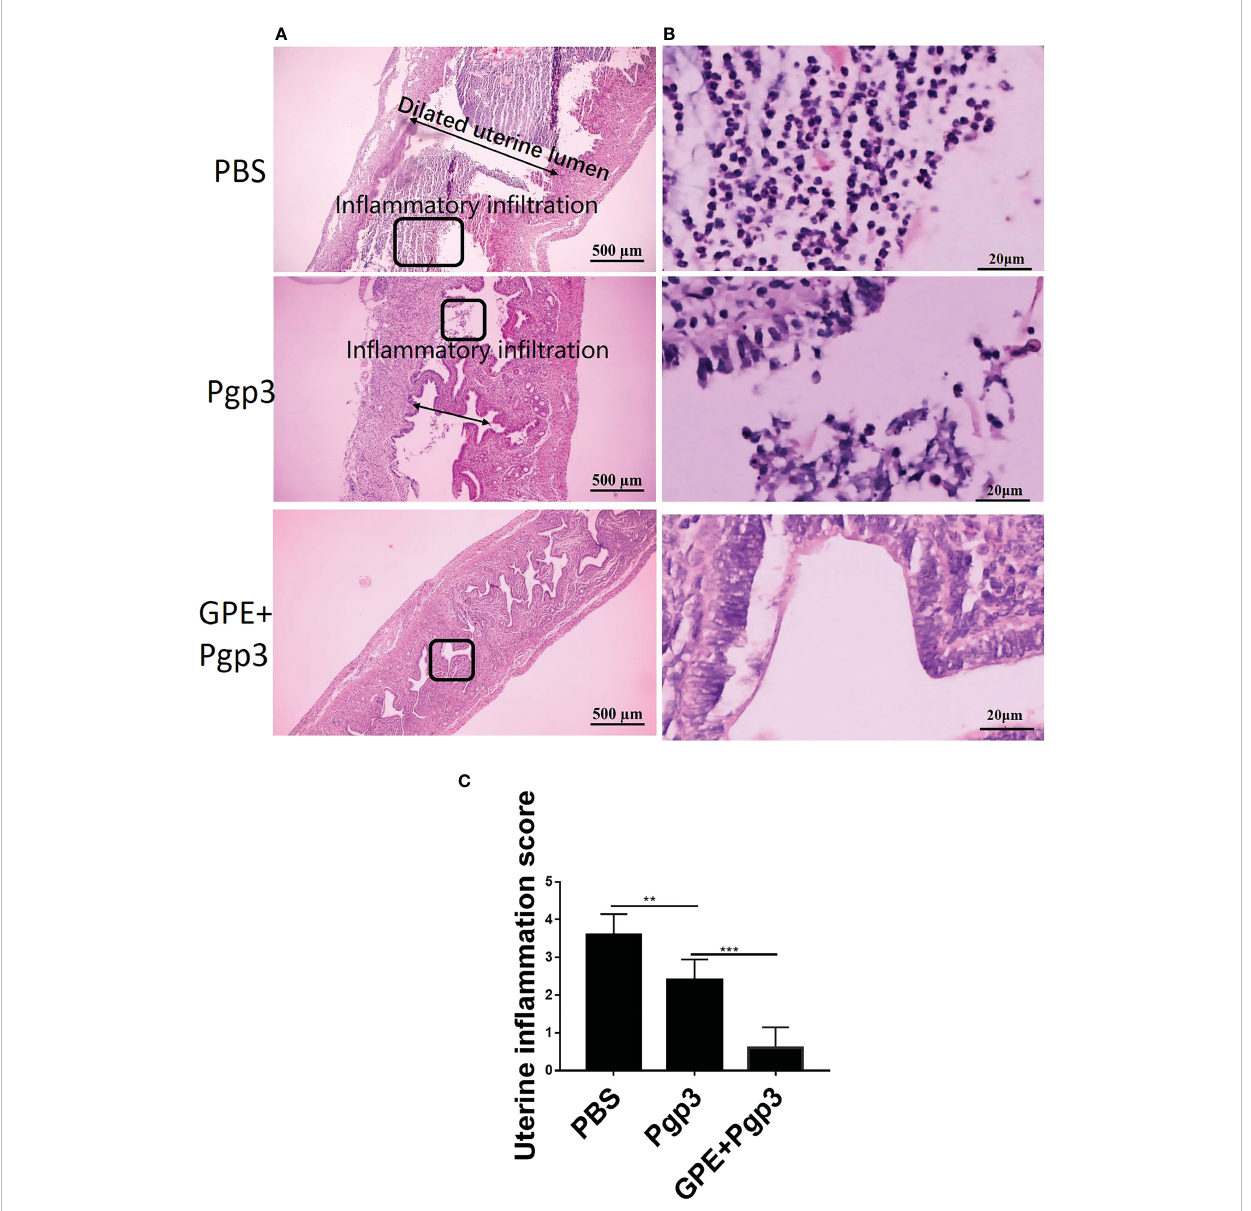
FIGURE 13 Microscopic observation of uterine horn dilation and in fl ammatory in fi ltration. The oviduct tissues of vaccinated mice were harvested 60 days post Chlamydia muridarum (C. muridarum) infection and subjected to H&E staining. (A) Representative images of the uterine. Images were magni fi ed ×50; (B) In fl ammatory in fi ltrated areas as indicated by the rectangles at ×1,000 magni fi cation; (C) histograms for uterine in fl ammation scores. n = 5. H&E, hematoxylin and